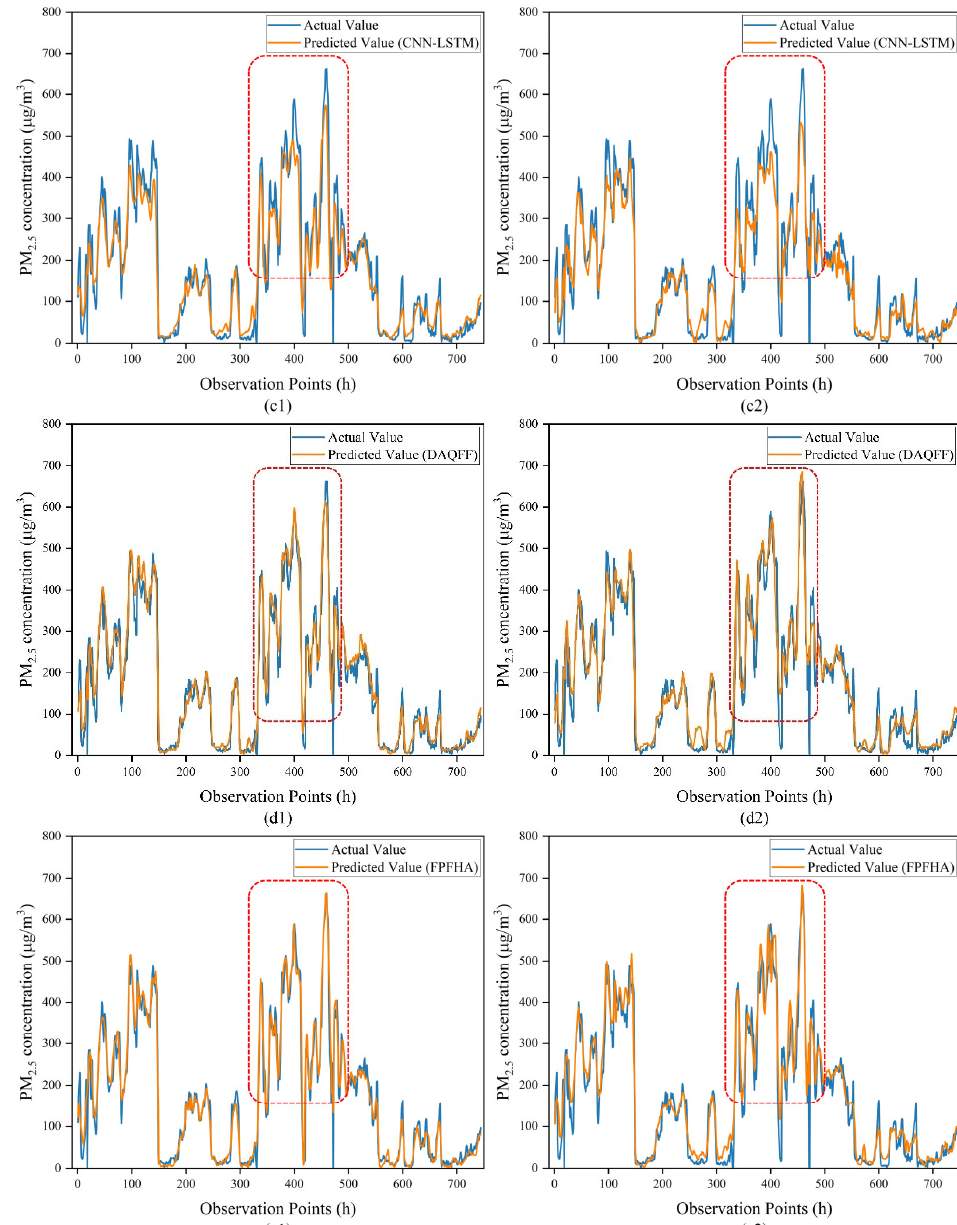
Figure 11. Comparison between actual value and predicted PM 2.5 value throughout the course of a month (16 December 2016–15 January 2017) for prediction steps of 24 h and 96 h, in experiments on the Beijing dataset, with different models (LSTM, GRU, CNN-LSTM, DAQFF, and FPHFA). ( a1 ) LSTM model for prediction 24 h ahead; ( a2 ) LSTM model for prediction 96 h ahead; ( b1 ) GRU model for prediction 24 h ahead; ( b2 ) GRU model for prediction 96 h ahead; ( c1 ) CNN-LSTM model for prediction 24 h ahead; ( c2 ) CNN-LSTM model for prediction 96 h ahead; ( d1 ) DAQFF model for prediction 24 h ahead; ( d2 ) DAQFF model for prediction 96 h ahead; ( e1 ) FPHFA model for prediction 24 h ahead; ( e2 ) FPHFA model for prediction 96 h ahead.